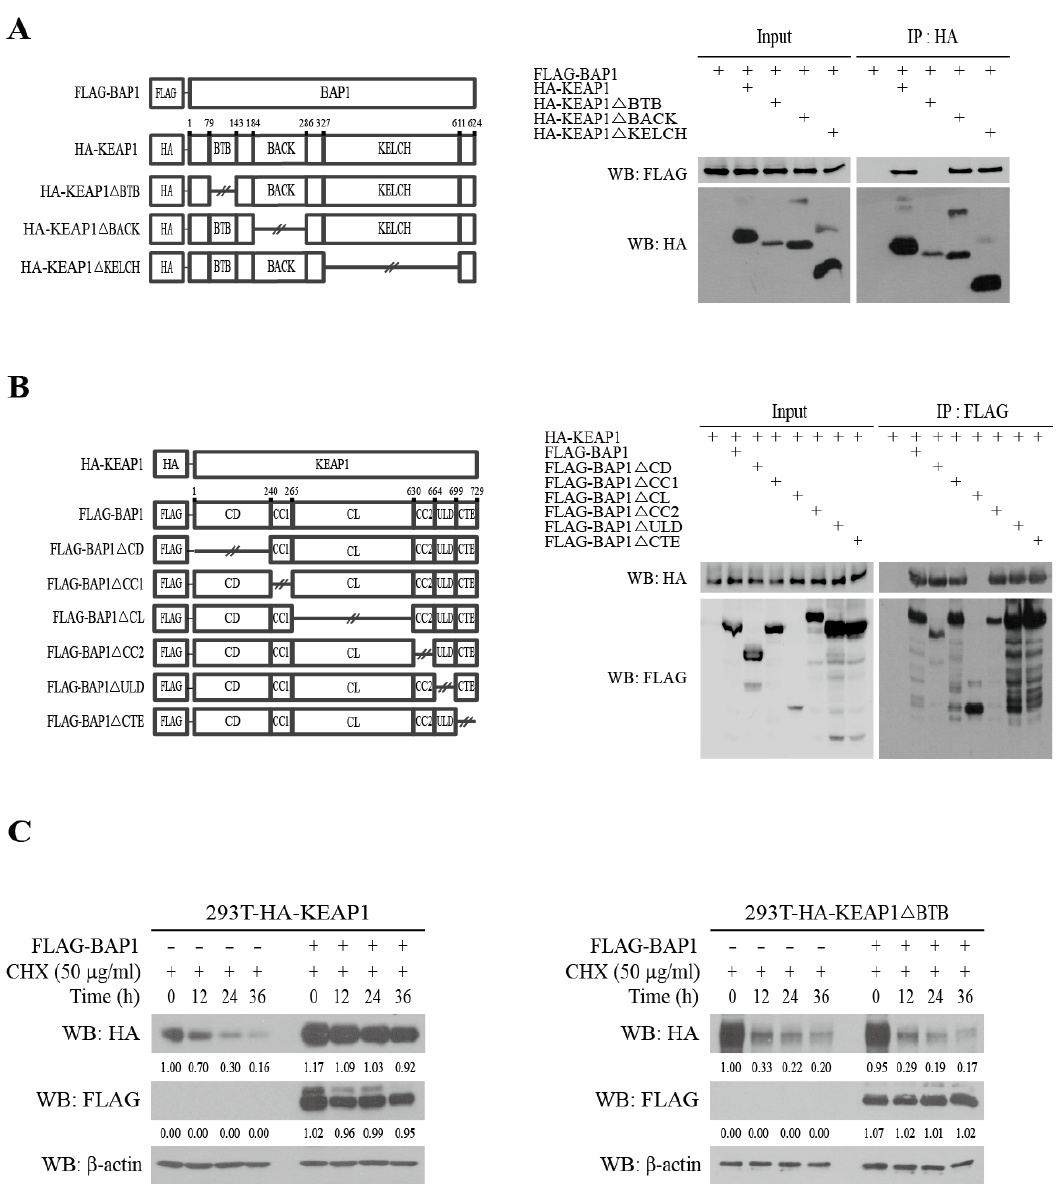
Figure 2. BAP1 stabilizes KEAP1 by binding to the BTB domain. ( A ) BAP1 binds to the BTB domain of KEAP1. Individual KEAP1 domains in pcDNA3-HA-KEAP1 plasmids were deleted by overlapping PCR ( left panel ). One µ g of pcDNA3-FLAG-BAP1 was cotransfected with 1 µ g of pcDNA3-HA-KEAP1 or 1 µ g of pcDNA3-HA-KEAP1 truncated mutants for 24 h in 293T cells (2.0 × 10 6 cells/100 mm dish). Cell lysates (1 mg) were immunoprecipitated with HA magnetic beads and Western blot was performed with FLAG-HRP and HA-HRP antibodies ( right panel ). ( B ) KEAP1 binds to the CL domain of BAP1. Individual BAP1 domains in pcDNA3-FLAG-BAP1 plasmids were deleted by overlapping PCR ( left panel ). One µ g of pcDNA3-HA-KEAP1 was cotransfected with 1 µ g of pcDNA3-FLAG-BAP1 or 1 µ g of pcDNA3-FLAG-BAP1 truncated mutants in 293T cells (2.0 × 10 6 cells/100 mm dish). Cell lysates were immunoprecipitated with FLAG magnetic beads, and Western blot analysis was conducted with HA-HRP and FLAG-HRP antibodies ( right panel ). ( C ) The BTB domain is necessary for the stabilization of KEAP1 by BAP1. The 293T-HA-KEAP1 cells and 293T-HA-KEAP1 ∆ BTB cells (2.0 × 10 6 cells/100 mm dish) were established by transfection of pcDNA3-puro-HA-KEAP1 and pcDNA3-puro-HA-KEAP1 ∆ BTB plasmids followed by selection with puromycin (2 µ g/mL) for 48 h. After transfection of 1 µ g of pcDNA3-FLAG-BAP1, 293T-HA-KEAP1 cells ( left panel ) and 293T-HA-KEAP1 ∆ BTB cells ( right panel ) were exposed to CHX for various times and Western blot analysis was conducted against HA-HRP and FLAG-HRP